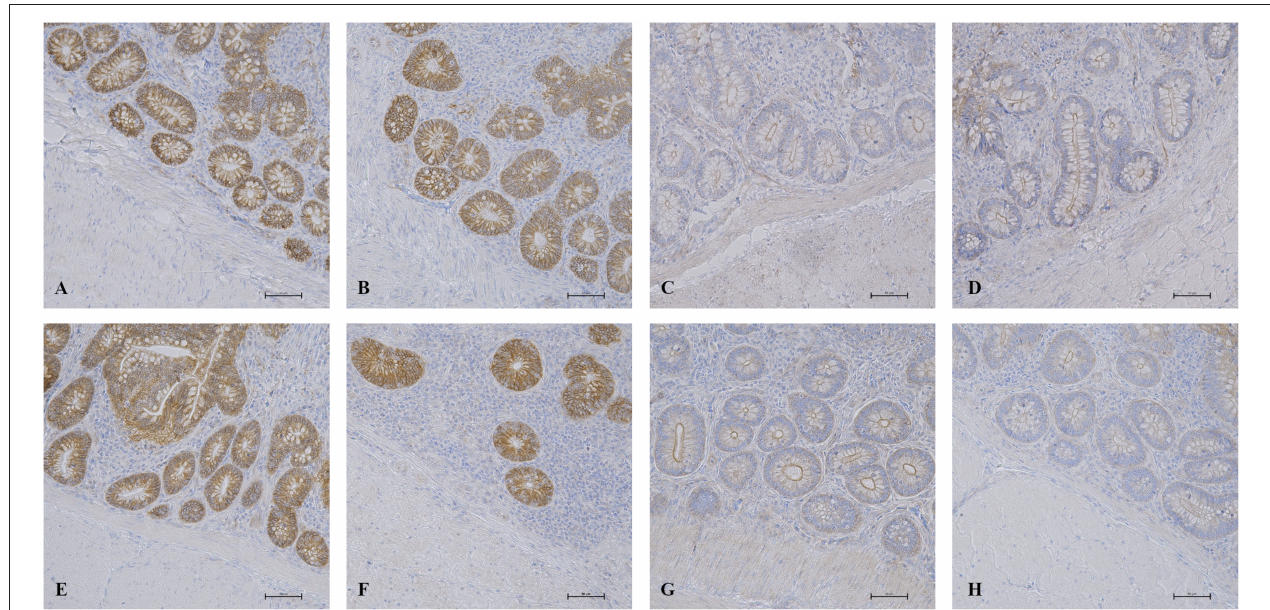
FIGURE 4 | IHC results in the intestinal mucosa. Histological pictures of claudin-3 in ileum (A) and cecum (B) of AM-treated groups and in ileum (E) and cecum (F) of K group. ZO-1 expression in ileum (C) and cecum (D) of AM-treated groups and in ileum (G) and cecum (H) of K group. IHC, 200x